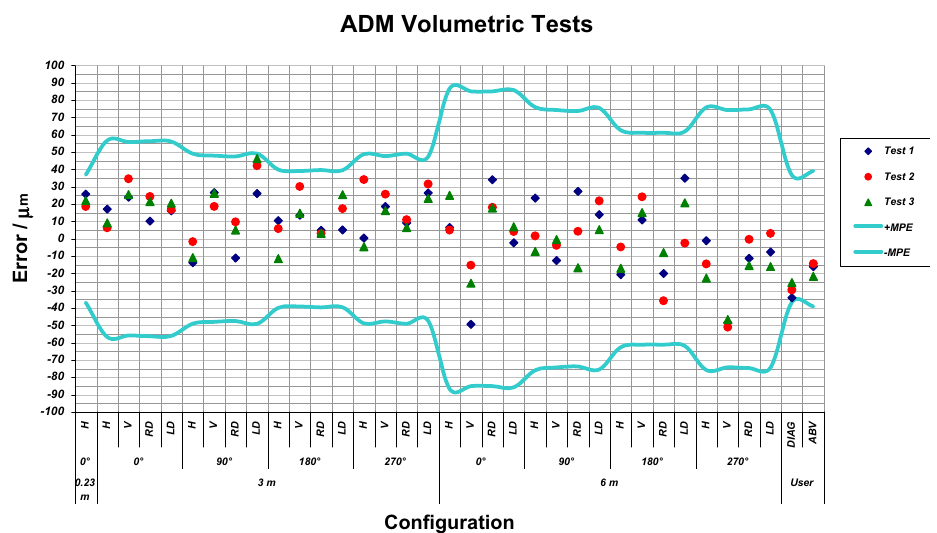
Fig. 9. Length measurement system test results (ADM